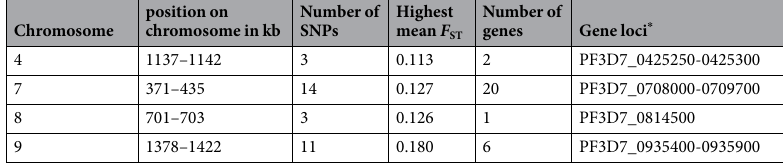
Table 2. Genomic windows of Plasmodium falciparum with highest geographical differentiation across the full set of West African populations analysed. * Each window contains at least 3 SNPs with mean F ST (across all population pairs) > 0.05 and at least one SNP with mean F ST > 0.10. Co-ordinates and gene loci are as described in the P. falciparum 3D7 reference genome version 3.1, which may be visualised in detail through the PlasmoDB genome browser 35